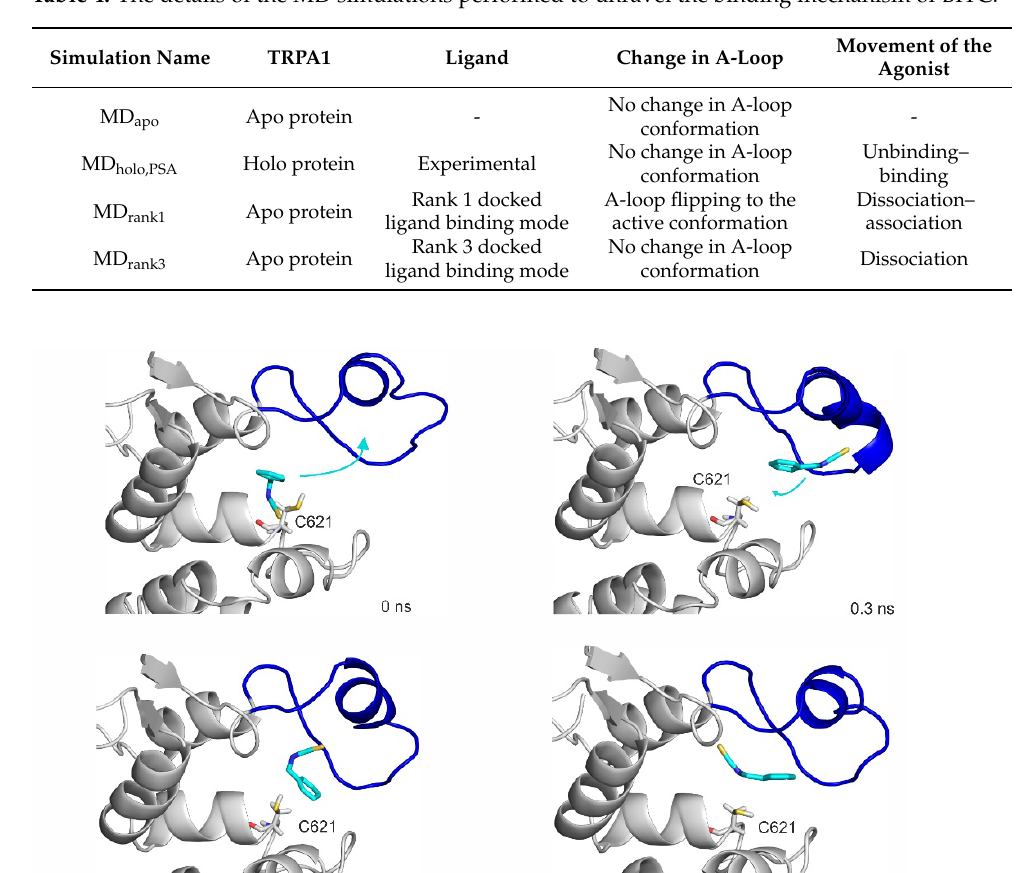
Table 4. The details of the MD simulations performed to unravel the binding mechanism of BITC.